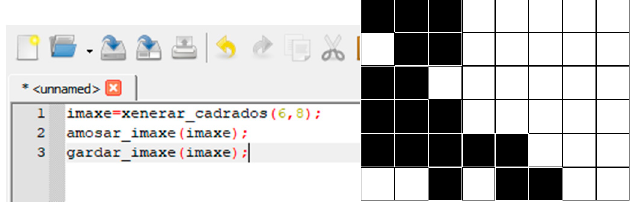
Figure 1. Example of code and output to generate random polygon over a grid.